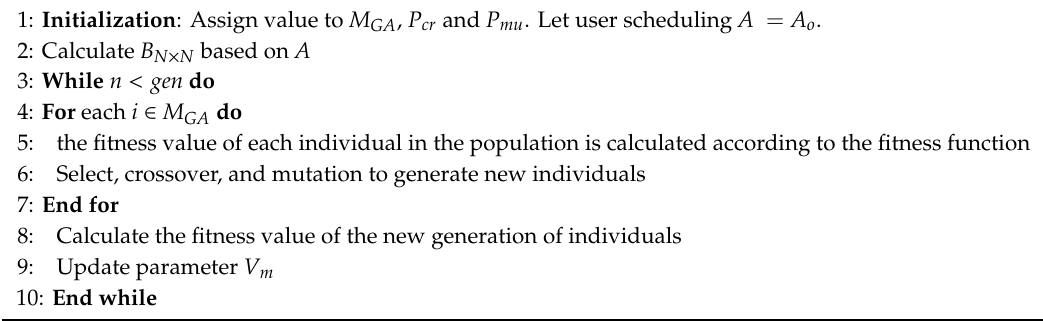
Algorithm 2 : Genetic